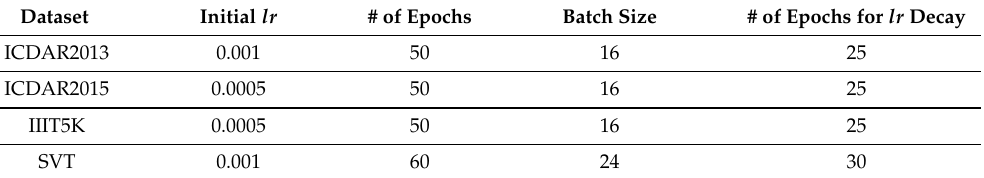
Table 1. Hyper-parameters for network training on evaluation datasets: lr represents the learning